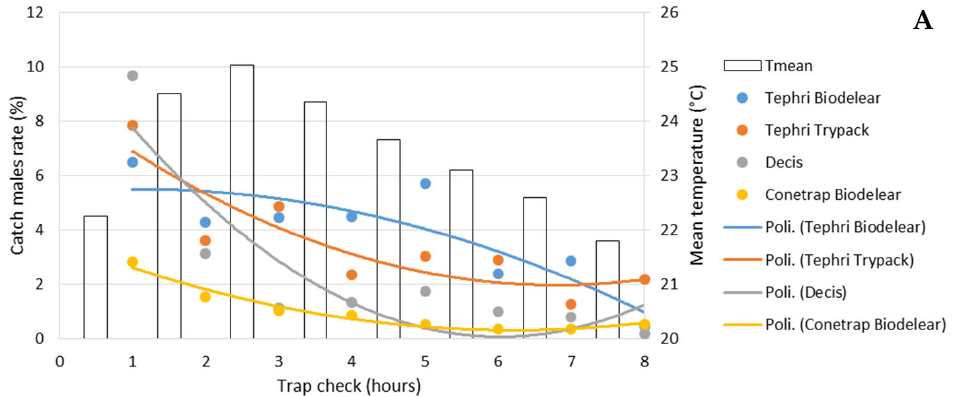
B Figure 5. Cont